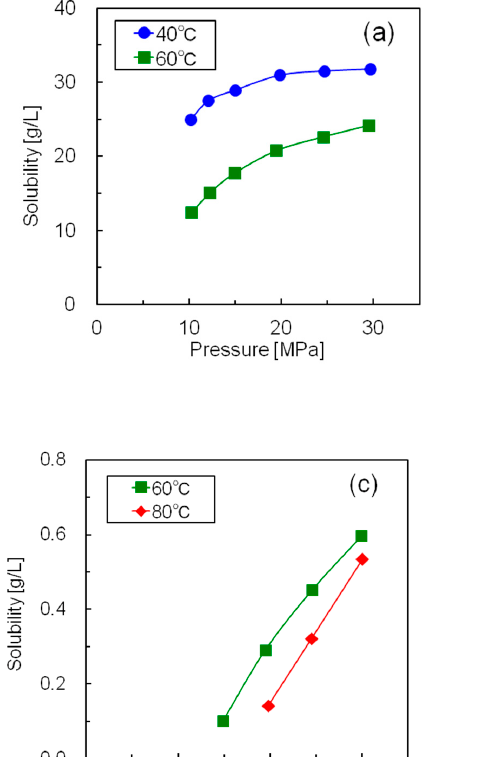
Figure 5. Solubilities of the five silicone resins at different temperatures and pressures in supercritical CO 2 ( a ) Resin S1; ( b ) Resin S2; ( c ) Resin S3; ( d ) Resin S4; ( e ) Resin S5. Figure 6 shows the influence of the side chain methyl-to-phenyl group ratio on the solubilities of the silicone resins. The free volume of the silicone resin increased as the ratio of methyl groups,